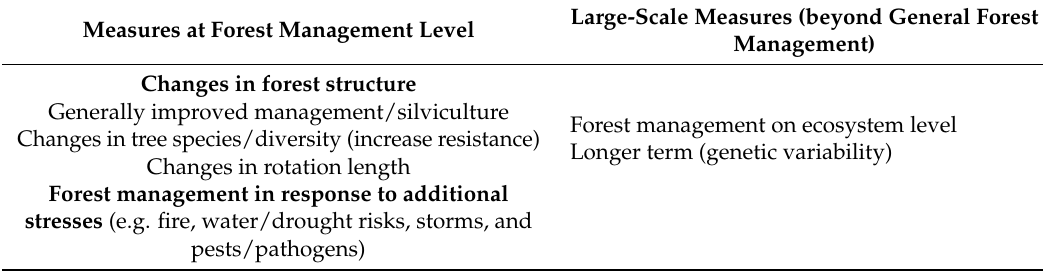
Table 2. Examples of management measures towards adaptation (modified for the Swedish situation from